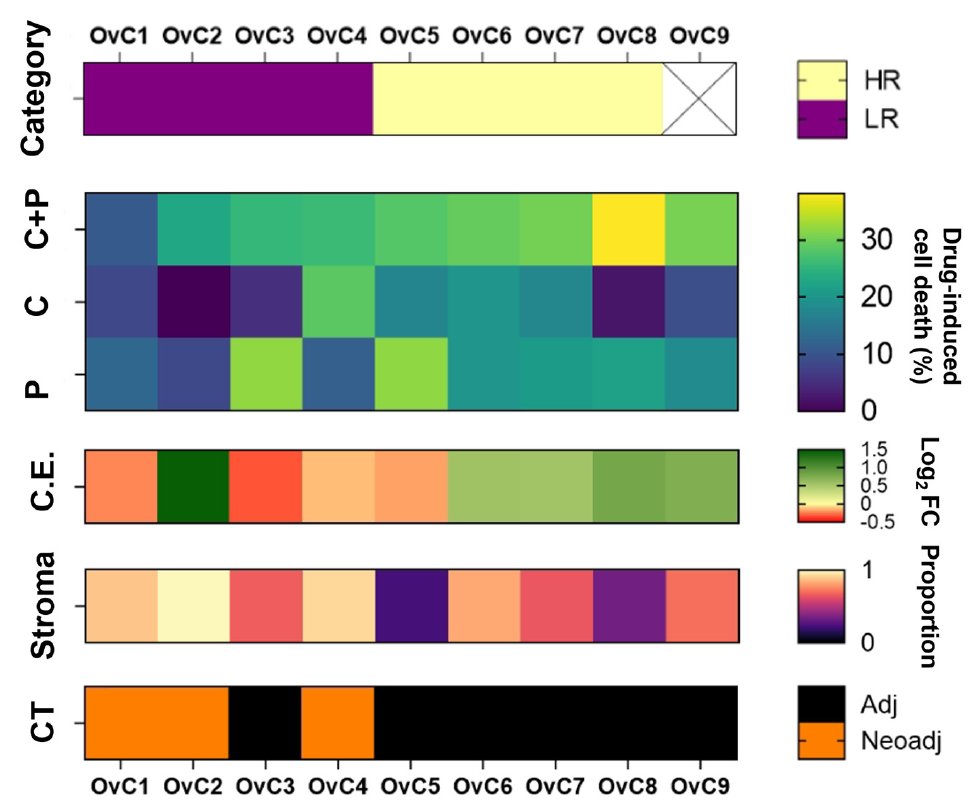
Figure 1. Sample-specific response to combination (carboplatin + paclitaxel) and single drugs cyclic drug exposure in serous ovarian carcinoma patient-derived ex vivo cultures and clinical information of the patient cohort. Ovarian carcinoma (OvC) patient-derived explants (PDE) cultures are categorized into high-responders (HR) and low-responders (LR) according to the ex vivo drug-induced cell death upon the first drug combination cycle, using the median as cut-off (OvC9 was excluded as it was the only low-grade serous carcinoma PDE). Patient sample-specific differences in drug-induced cell death, combination effect (C.E.), stroma proportion and clinical chemotherapy (CT) regimen are captured in the heatmap, (C: carboplatin; P: paclitaxel).